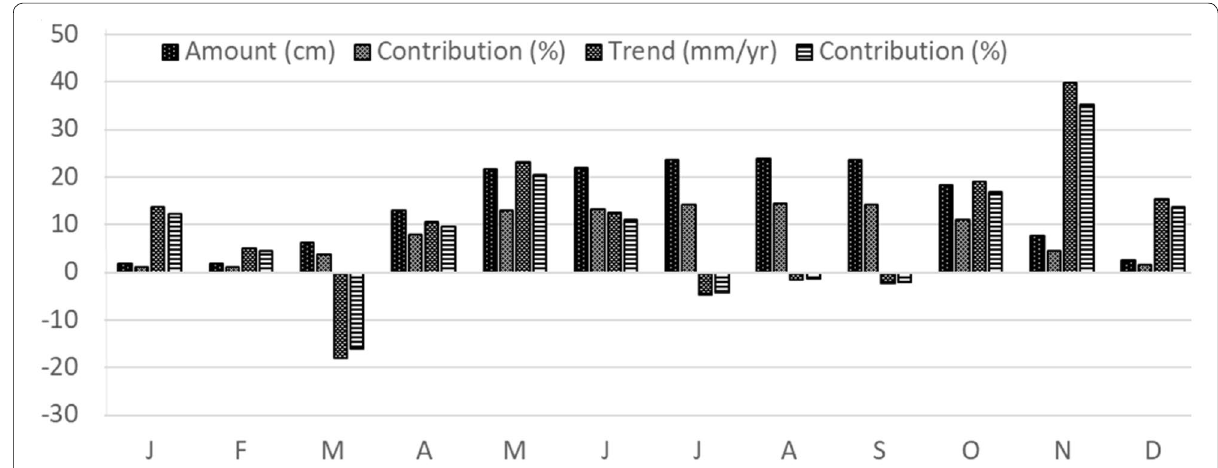
Fig. 2 Monthly rainfall (in cm), contribution to the annual total (in %), Monthly rainfall trends (mm/10 yr), and contribution to the annual rainfall trend (in %) left in Alwero